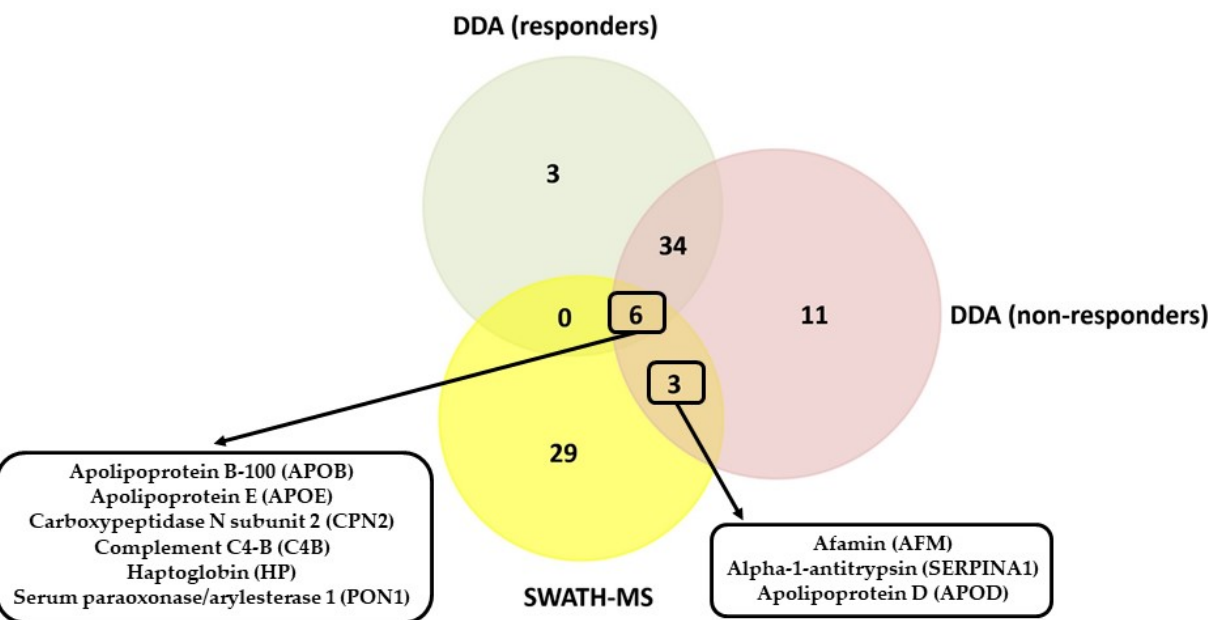
Figure 4. Comparison of the results obtained by the DDA analysis (qualitative) and the SWATH-MS analysis (quantitative).